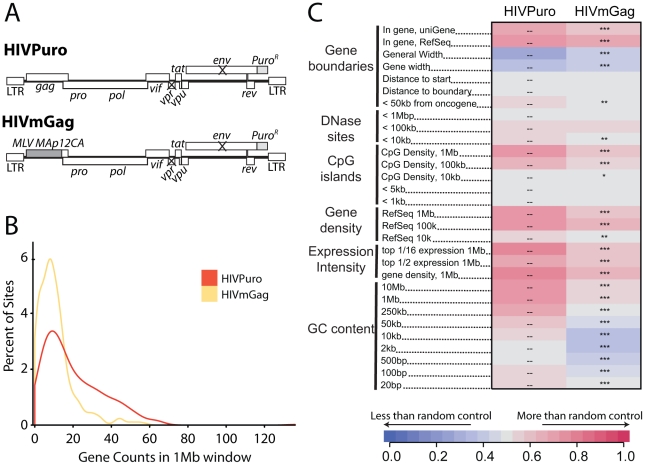
A chimeric derivative of HIV containing MLV gag (HIVmGag) shows reduced integration frequency in gene dense regions.(A) Genetic map of HIV proviruses containing wild type gag (HIVPuro) or a chimera encoding MLV Gag (MA, p12, and CA) in place of HIV MA and CA (HIVmGag). Both viruses have inactivated vpr and env and a puromycin selectable marker in place of nef. (B) Histogram indicating distribution of HIVPuro and HIVmGag integration sites with respect to gene density measured in 1 Mb intervals surrounding integration events. Data is plotted as in Fig. 1C and curves are computed using Gaussian kernel density estimates. (C) Genomic heatmap of HIVPuro and HIVmGag datasets. Significant differences are shown by asterisks (*p<0.05; **p<0.01; ***p<0.001). Annotations at the left of the heat map are as in Figure 2 and described in Text S1. An interactive version of this figure is available as Figure S8.